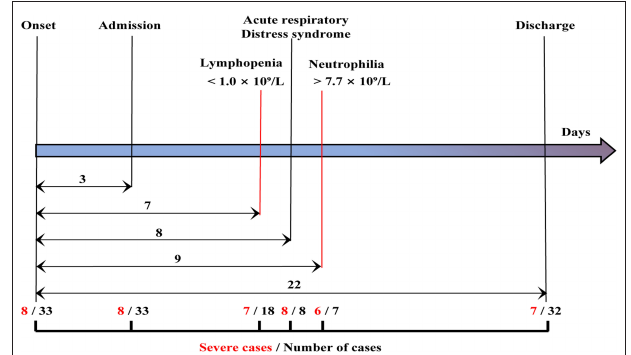
FIGURE 1 | Clinical courses of the study patients. The time lines showed the days of hospital admission, lymphopenia, acute respiratory distress syndrome, neutrophilia, and discharge from symptom onset for each case. The median time from onset of symptoms to hospital admission and discharge was 3, 22 days, respectively. Among the 33 patients (black), eight cases were severe cases (red). A total of 18 cases exhibited lymphopenia within 7 days, including seven severe patients. All eight patients presented with acute respiratory distress syndrome within 8 days. Seven cases presented with neutrophilia, including six severe cases within 9